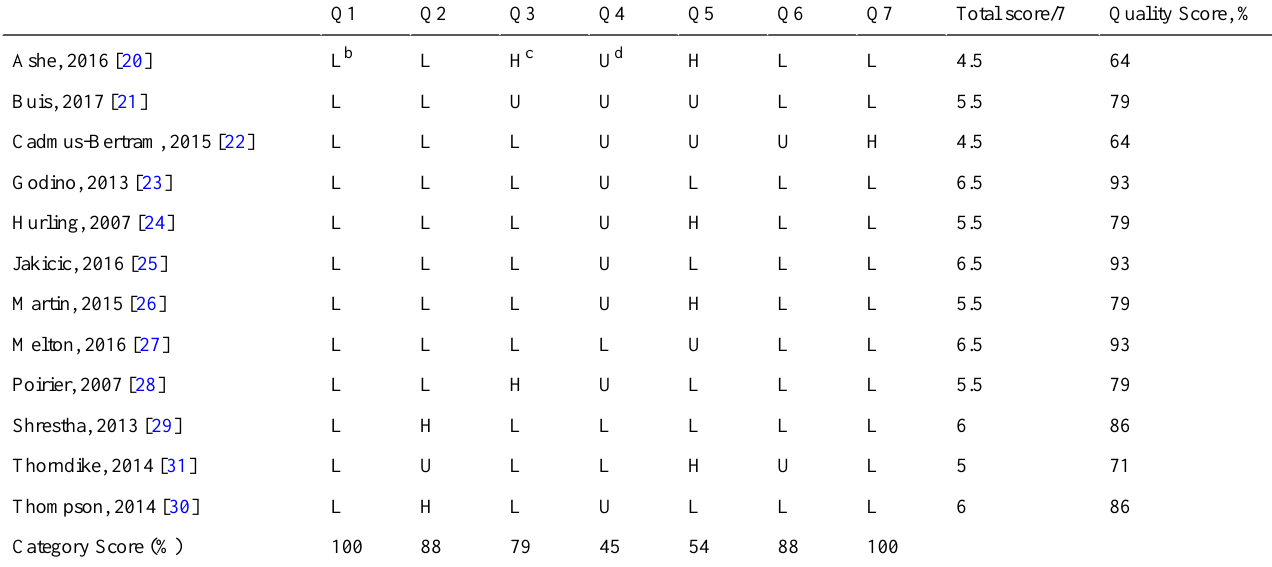
Table 3. Risk of bias (Cochrane Critical Appraisal Skills Program Tool a